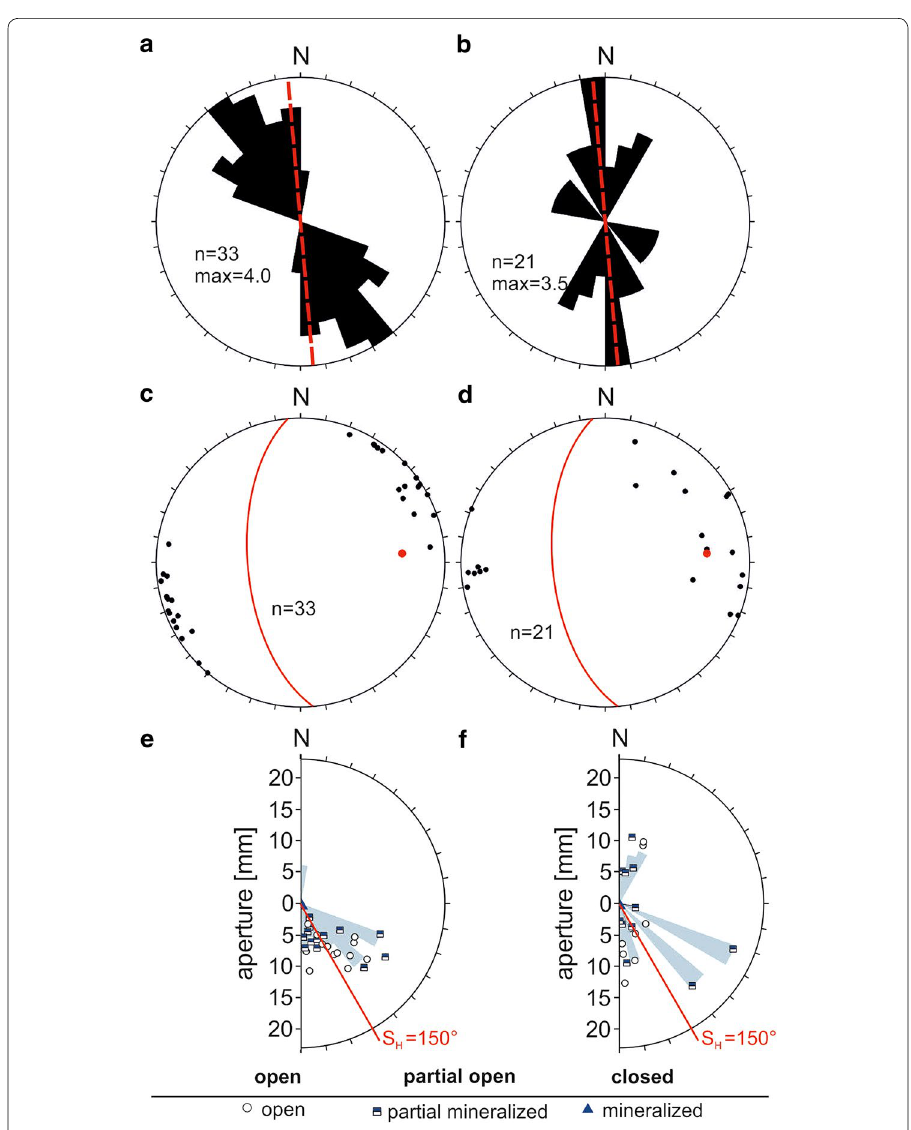
Fig. 13 Fracture properties derived from the FMI log (analysed and provided by J. Reinecker). a , b The fracture orientations, above and below 3270 m depth, respectively, in equal area‑scaled rose diagrams with 10° bin size. The dashed red line shows the strike of the fault that cuts through the reservoir. c , d The cor‑ responding pole plots (equal area, lower hemisphere) with the great circle showing the fault orientation. e , f Half‑circular diagrams showing the relation between fracture strike, with respect to aperture and fracture fill‑ ing. Rose diagrams scaled for mean aperture for 10° bins. The red lines indicate the local maximum horizontal stress direction from the well (Reinecker et al.